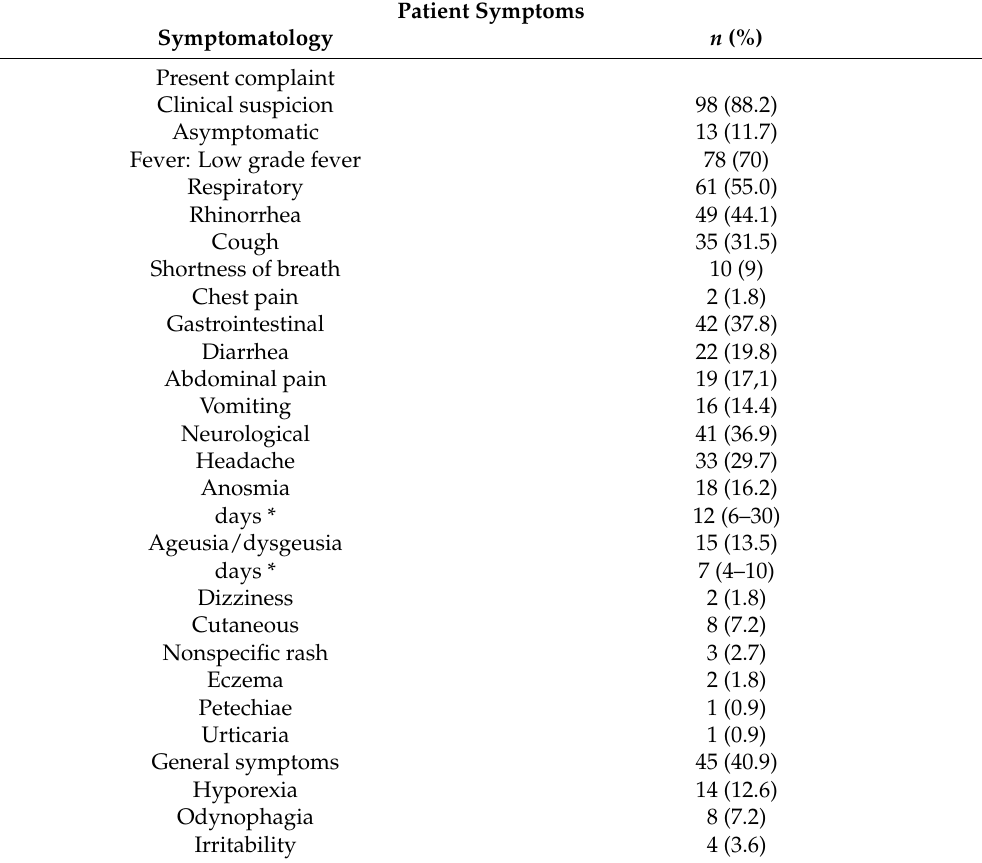
Table 2. Patient